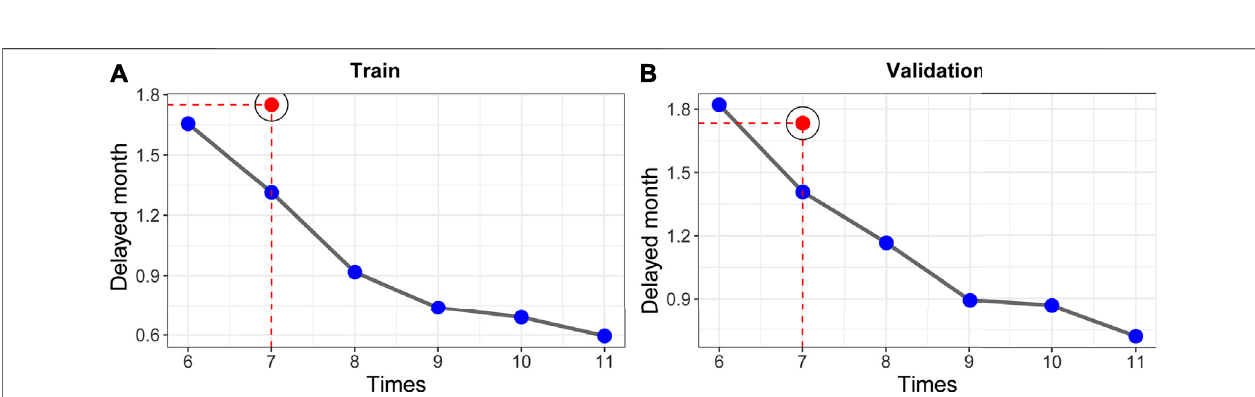
FIGURE 4 | Establishment of risk-based surveillance arrangements. (A,B) In contrast with the control strategy (7 times, which was put forward in a cooperative meeting of ECIO and ESOI), our surveillance arrangements (blue points with gray curve connected) had fewer delayed-detection days.